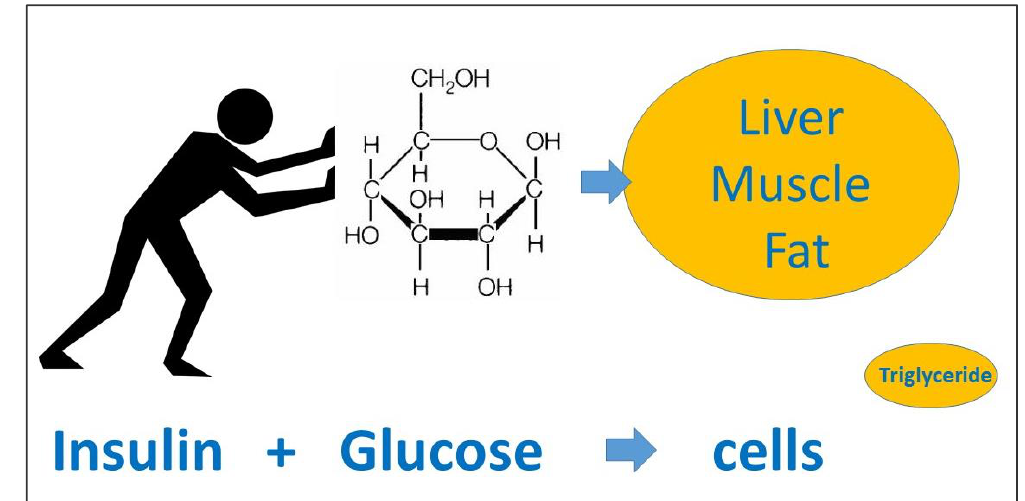
Figure 3. A useful model for explaining the physiology of Type 2 diabetes (T2D) to patients created by